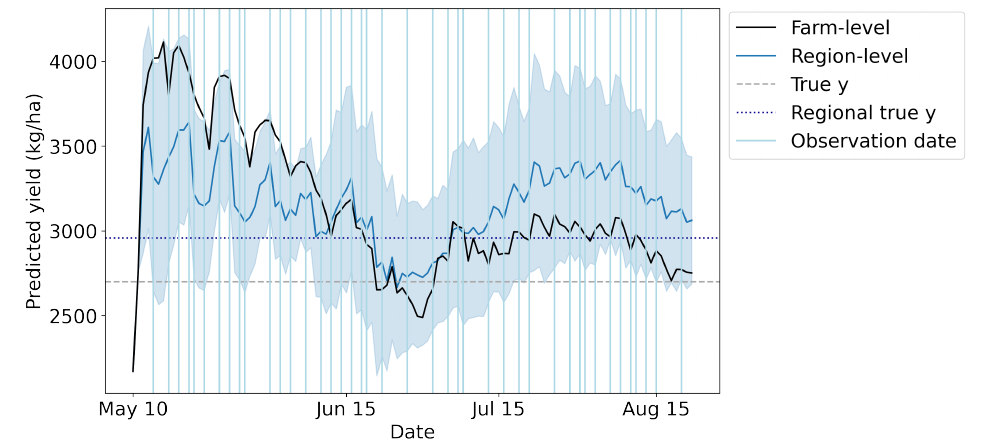
Figure 11. An example of in-season TCN predictions of spring wheat yield (kg/ha) of a farm and its surrounding region (municipality) in 2020 from cloud-masked data. Blue vertical lines denote observation dates. The region-level prediction is reported as the mean of all farm-predictions with the standard